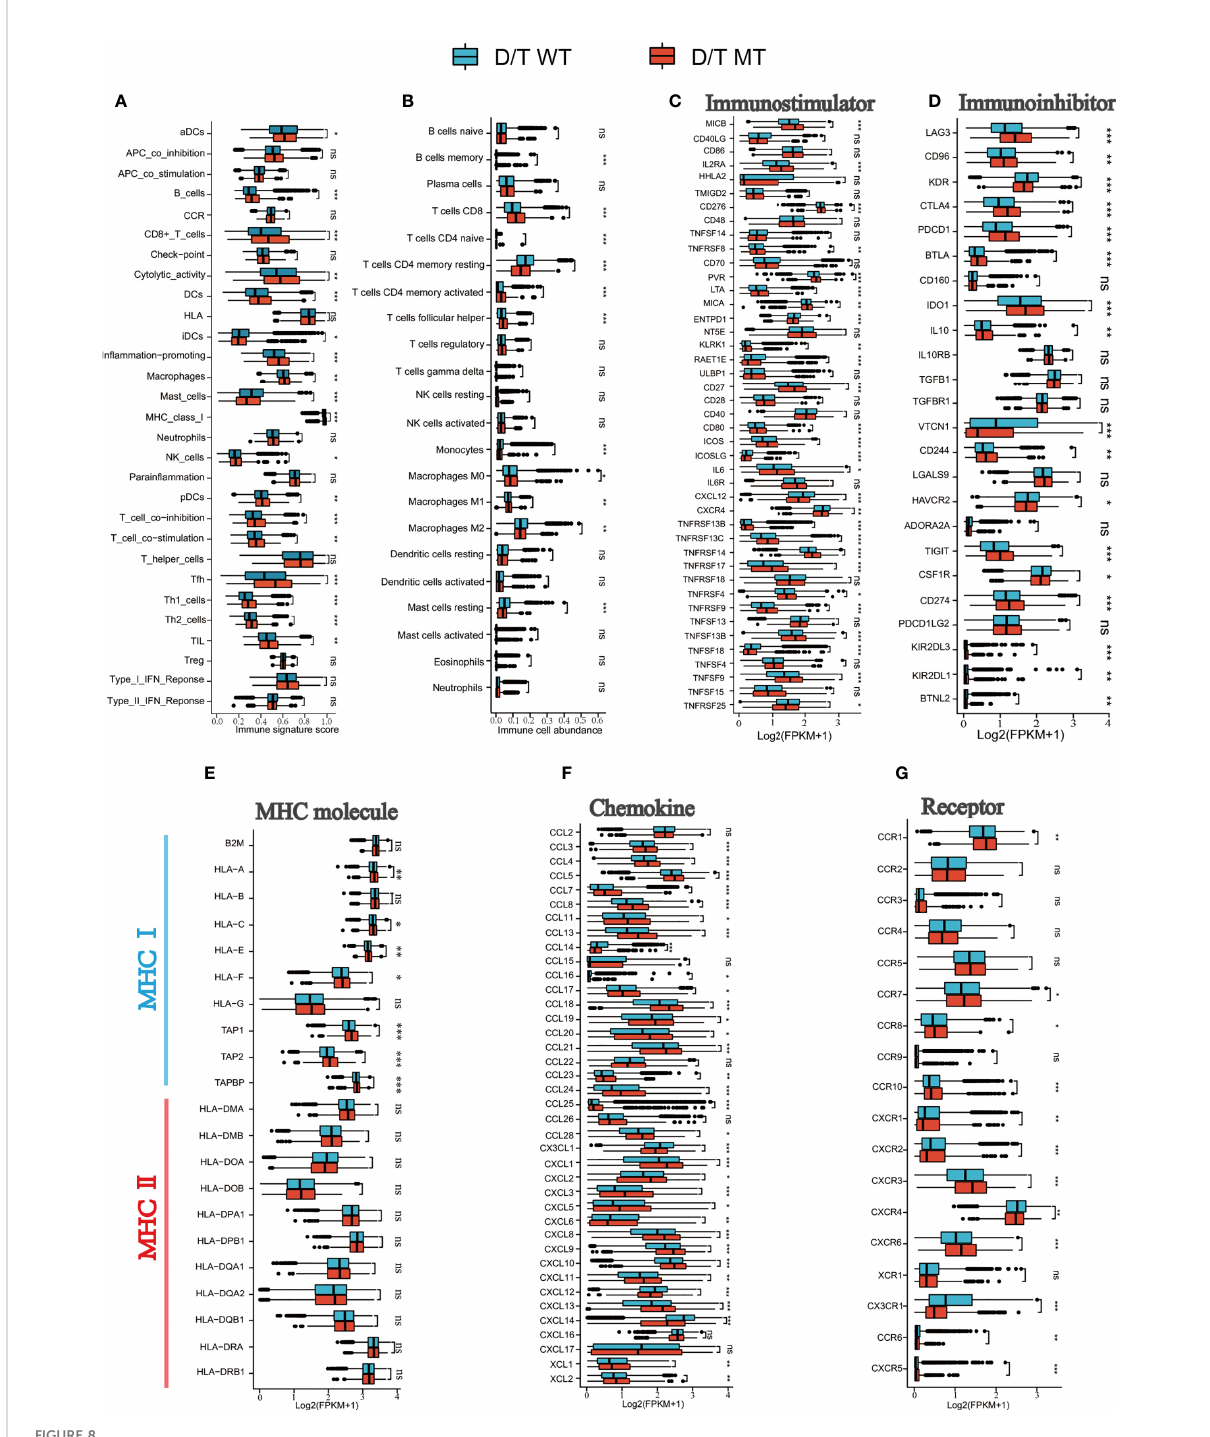
FIGURE 8 PTPRD/PTPRT mutation was associated with enhanced anti-tumor immunity in the TCGA cohort. (A) The correlation between PTPRD/PTPRT mutation and 29 immune signatures was analyzed using the ssGSEA method based on RNA-sequencing data. (B) Boxplot Pro fi ling the in fi ltration of 22 immune cells between PTPRD/PTPRT mutant and WT tumors. (C) Analysis of the levels of immunostimulators between PTPRD/PTPRT mutant and WT tumors. (D) Analysis of the levels of immunoinhibitors between PTPRD/PTPRT mutant and WT tumors. (E) Analysis of the levels of MHC molecules between PTPRD/PTPRT mutant and WT tumors. (F) Analysis of the levels chemokines between PTPRD/PTPRT mutant and WT tumors. (G) Analysis of the levels receptors between PTPRD/PTPRT mutant and WT tumors (* P < 0.05, ** P < 0.01, *** P < 0.001, ns, no signi fi